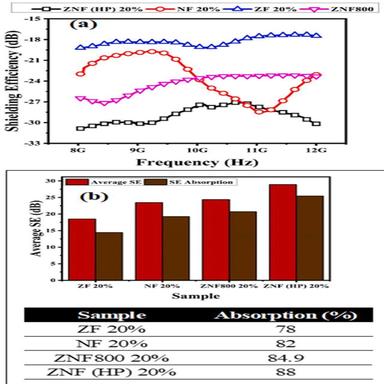
(a) Shielding Efficiency of 20% filler concentration of 2-layer ZNF(HP), NF, ZF and ZNF800 (b) Comparison between EM absorption of all the 4 samples.